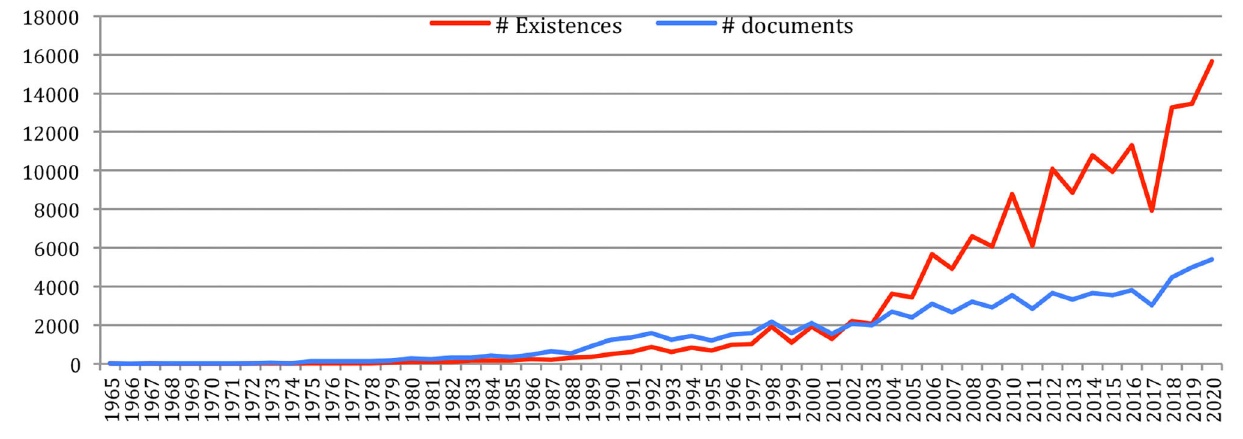
FIGURE 51 | Evolution of the number of papers and of mentions of language resources in papers over the years.